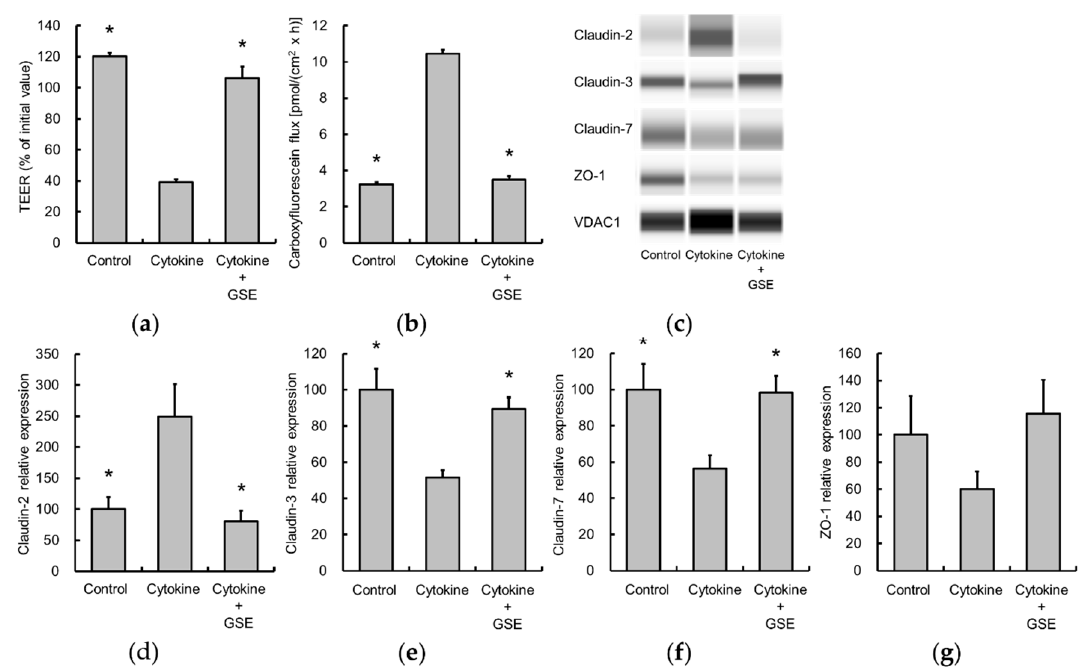
Figure 6. Effect of GSE on disruption of epithelial barrier function by IL-6 and IL-1 β treatment in Caco-2 cell monolayers. GSE treatment reverted the barrier dysfunction as determined by TEER ( a ) and carboxyfluorescein flux ( b ) in the presence of cytokines (10 ng / mL). TJ protein expression was evaluated using a ProteinSimple Wes system and normalized VDAC1. Representative images are indicated ( c ). Cytokines increased claudin-2 ( d ) and decreased claudin-3 ( e ) and claudin-7 ( f ), which were restored by GSE. ZO-1 expression was not changed significantly ( g ). Data are presented as the mean ± S.E.M of six monolayers in each group. * p < 0.05 vs. Cytokine group. GSE, grape seed extract, IL, interleukin, TEER, transepithelial electrical resistance, TJ, tight junction, VDAC1, Voltage-dependent anion-selective channel 1, ZO-1, zonula occludens-1.